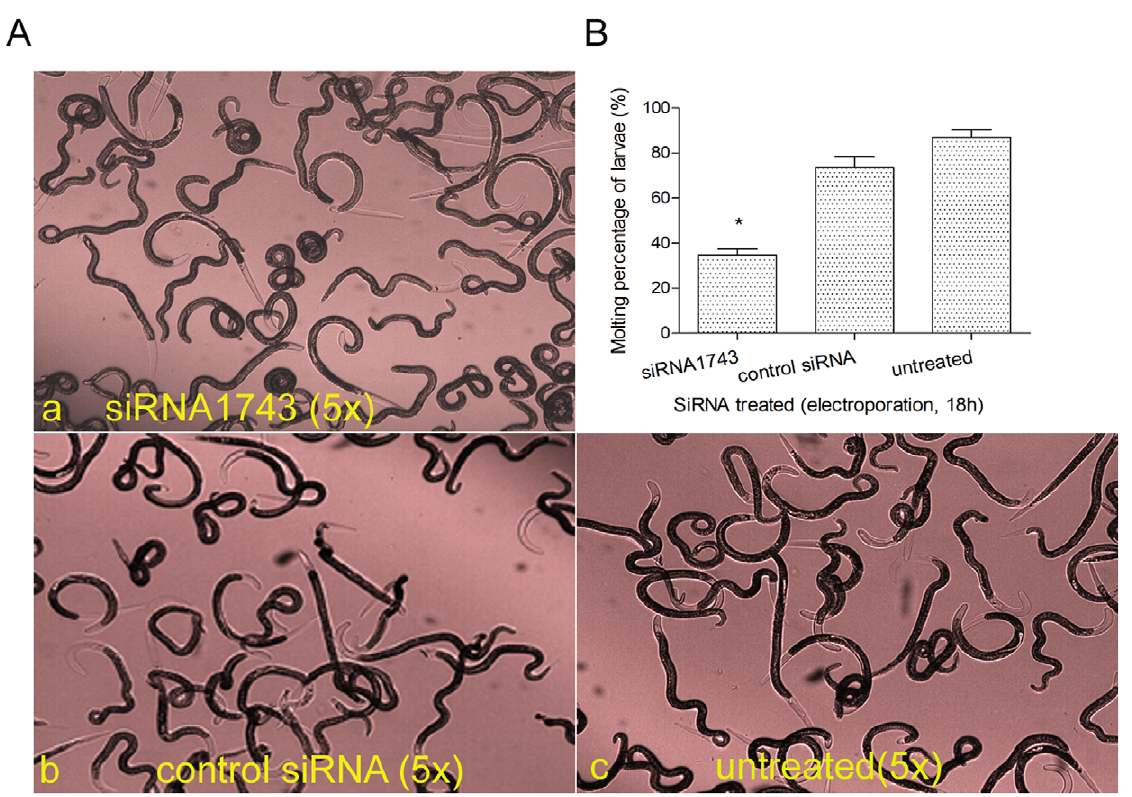
Figure 5. Suppression of Ts - pmy mRNA expression by siRNA1743 caused defects in larval molting. A. The larvae were electroporated with 8 m M siRNA1743 (a) or control siRNA (b) and incubated for 18 hours. The untreated larvae (c) were used as a negative control. The larvae with cuticle sheath at the end(s) were counted as molting ones. B. The molting percentage for each treatment was calculated. All of the assays were performed in triplicate. * p , 0.05 compared with the control siRNA-treated